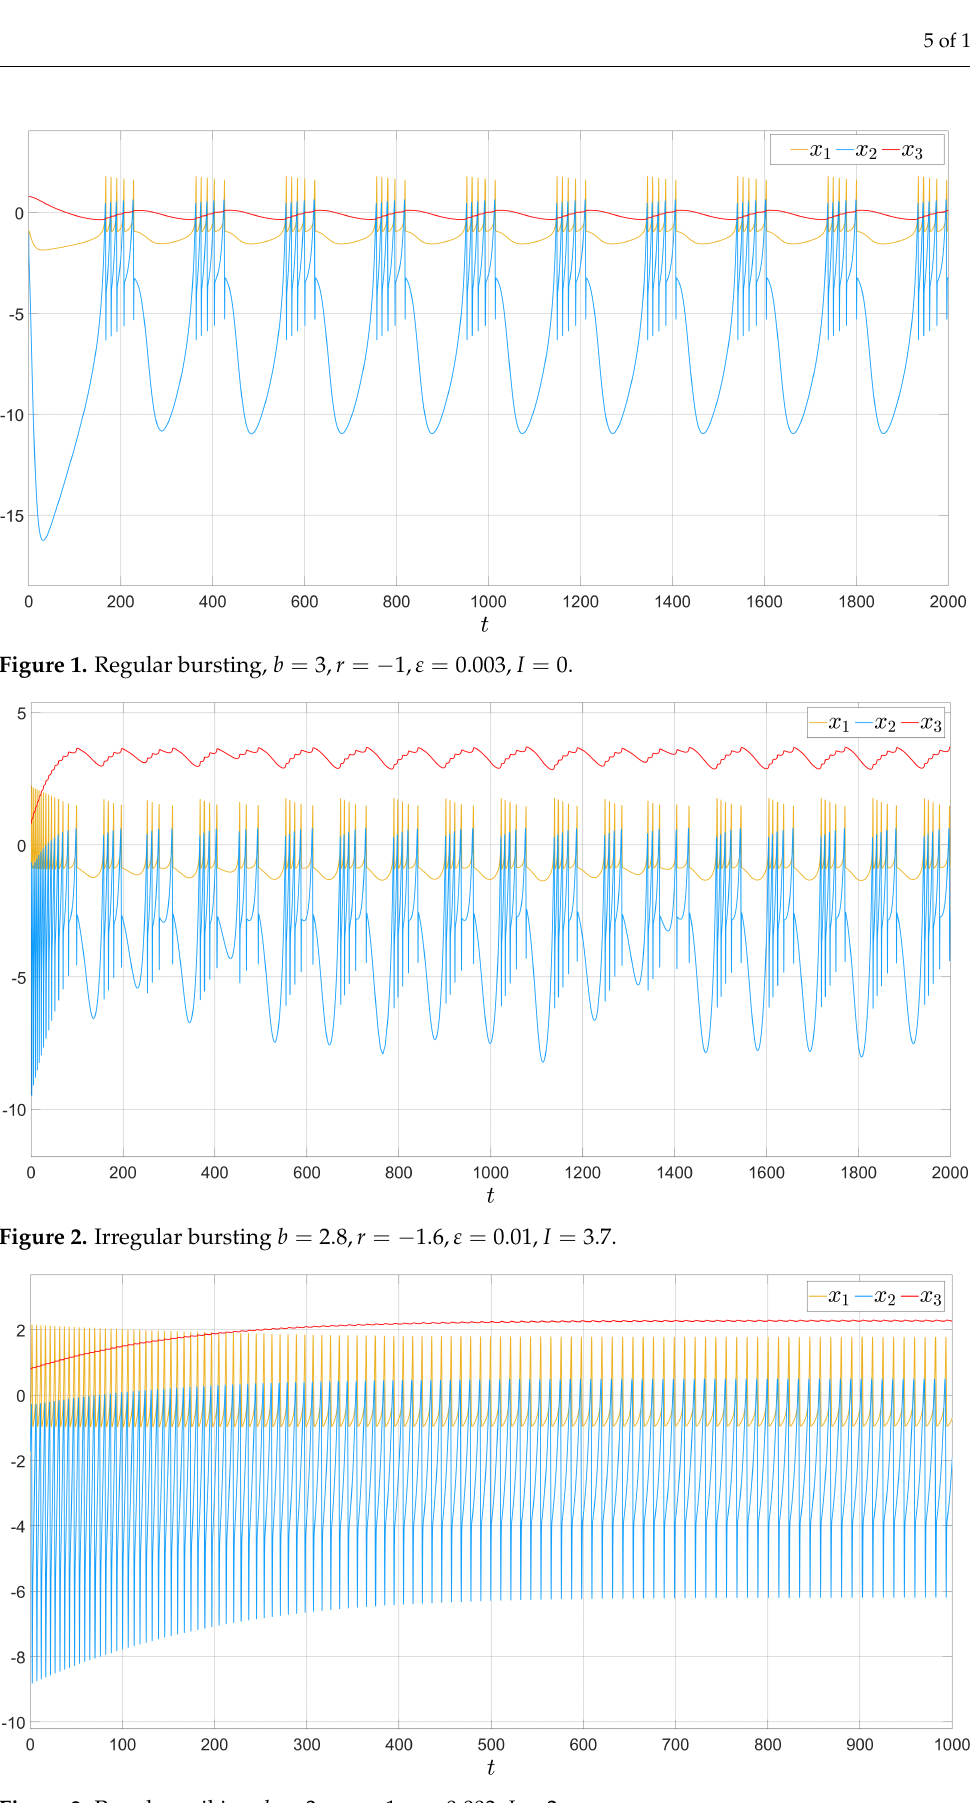
Figure 3. Regular spiking, b = 3, r = − 1, ε = 0.003, I =